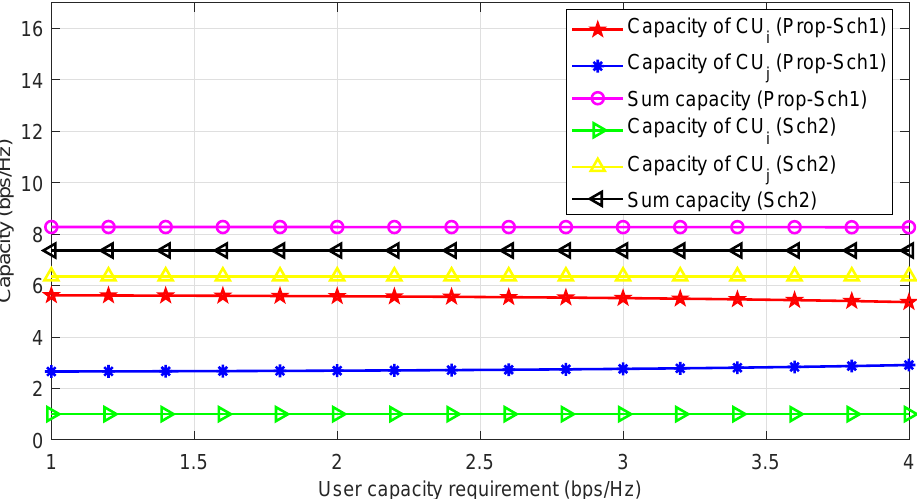
Figure 5. Comparison of Prop-Sch1 and Sch2 when setting the C 1 = 1 bps/Hz and increasing the Rate requirement of other